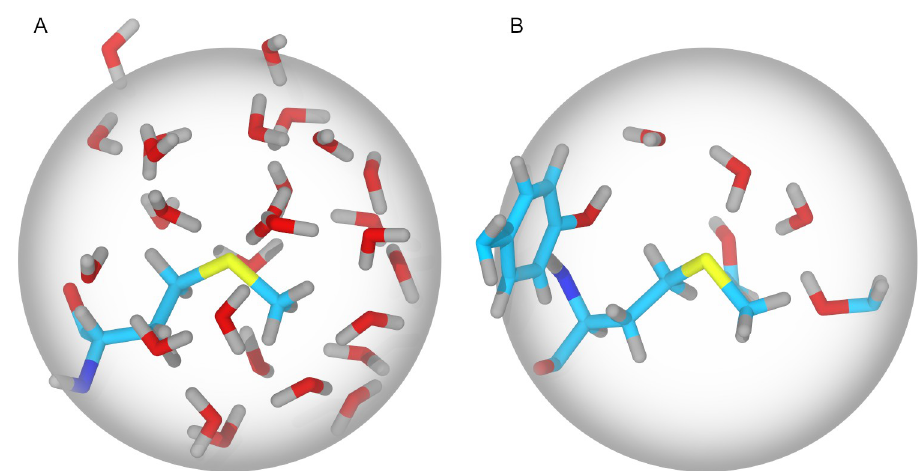
Fig 2. Representation of the two-shell water coordination number (WCN) and the WCN-OH variant. (A) For a methionine with the side chain exposed to the solvent, the water molecules within 6 Å from the sulfur atom are shown. (B) For a methionine with the side chain only partially exposed to the solvent, water molecules and side chains containing a hydroxyl group are shown. Carbon atoms are colored in cyan, oxygen in red, hydrogen in gray, nitrogen in blue and sulfur in yellow. The sphere represents the 2-solvation shell (radius 6 Å